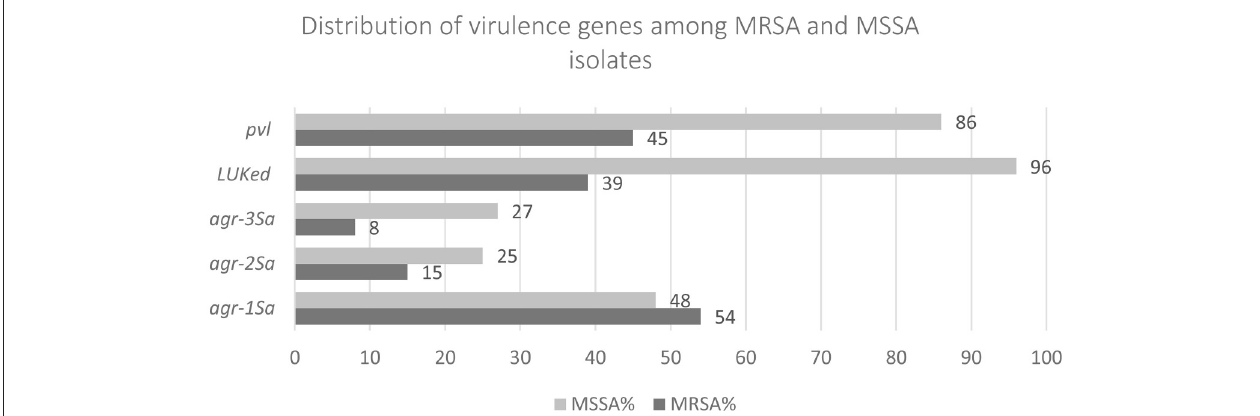
FIGURE 1 | The percentage of virulence genes detected in MSSA isolates is higher than MRSA.